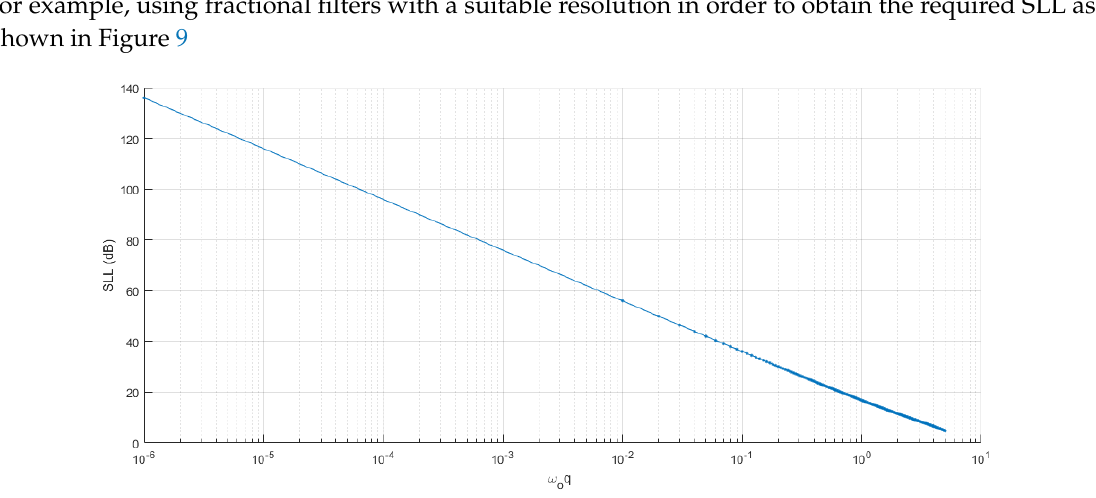
Figure 9. SLL as a function of the product ω o q .